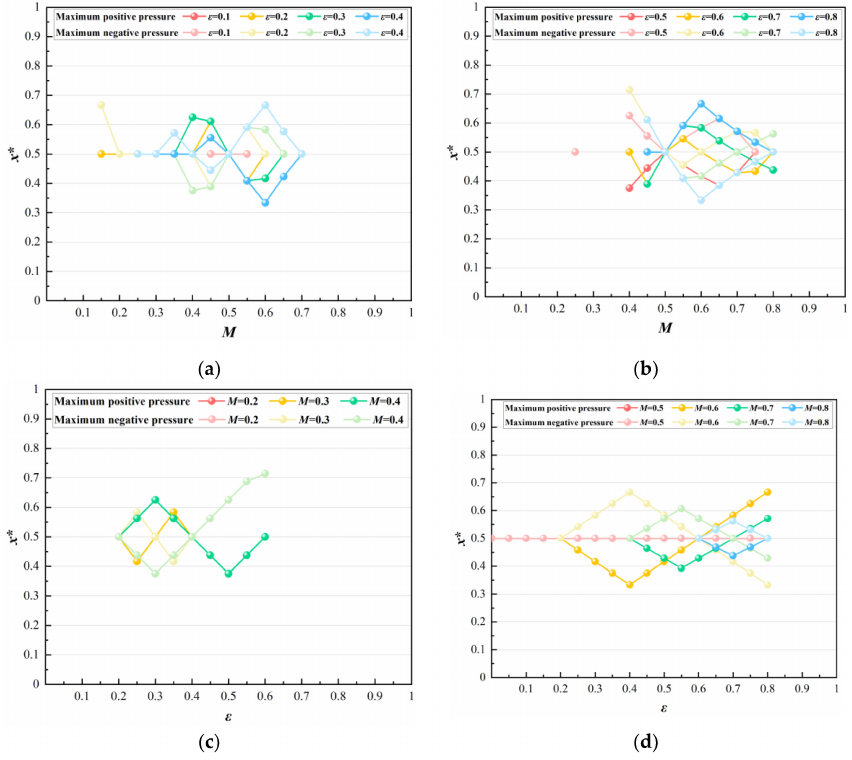
Figure 9. Change in the location of the maximum positive and negative pressures with different train/wave velocity ratios M and train/tunnel length ratios ε : ( a ) ε = 0.1–0.4, M ≤ 0.8; ( b ) ε = 0.5–0.8, M ≤ 0.8; ( c ) M = 0.1–0.4, ε ≤ 0.8; and ( d ) M = 0.5–0.8, ε ≤